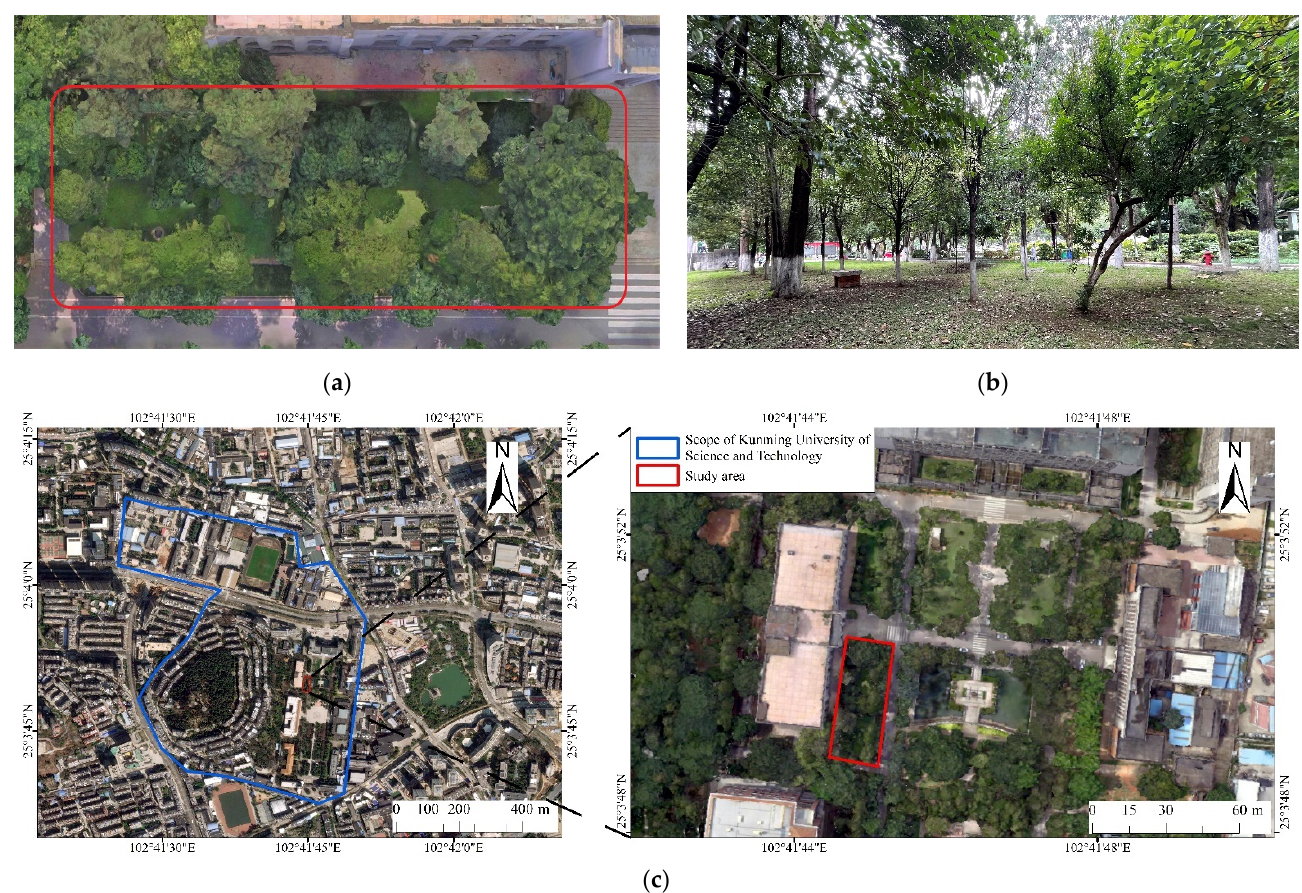
Figure 3. Overview of experimental area. (( a ) shows the whole; ( b ) shows the part; ( c ) shows the geographical location of the study